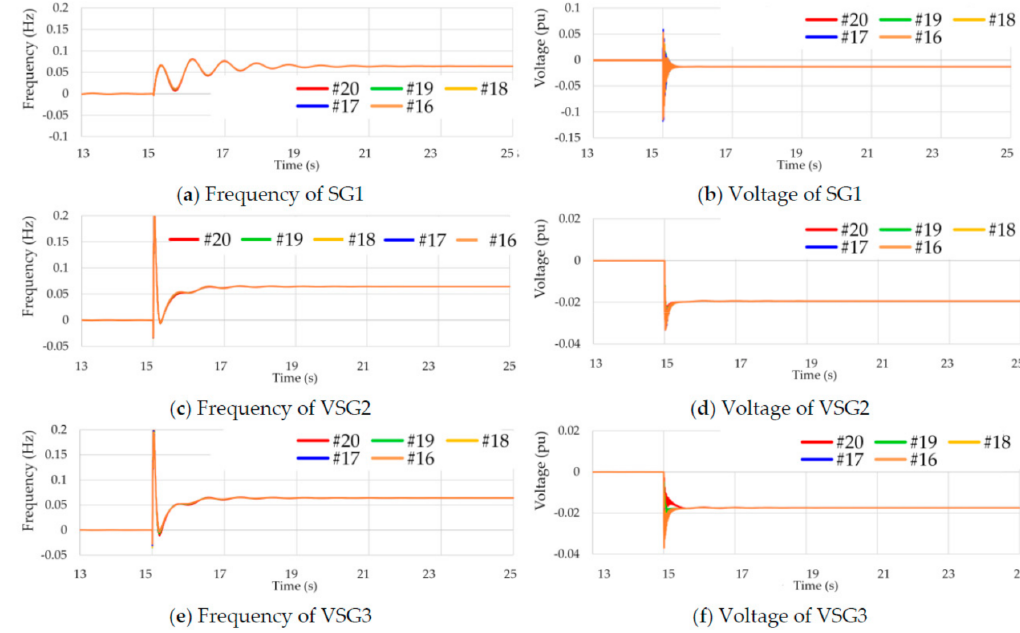
Figure 7. Transient responses of frequency and voltage for tests 16–20 in Table 1.